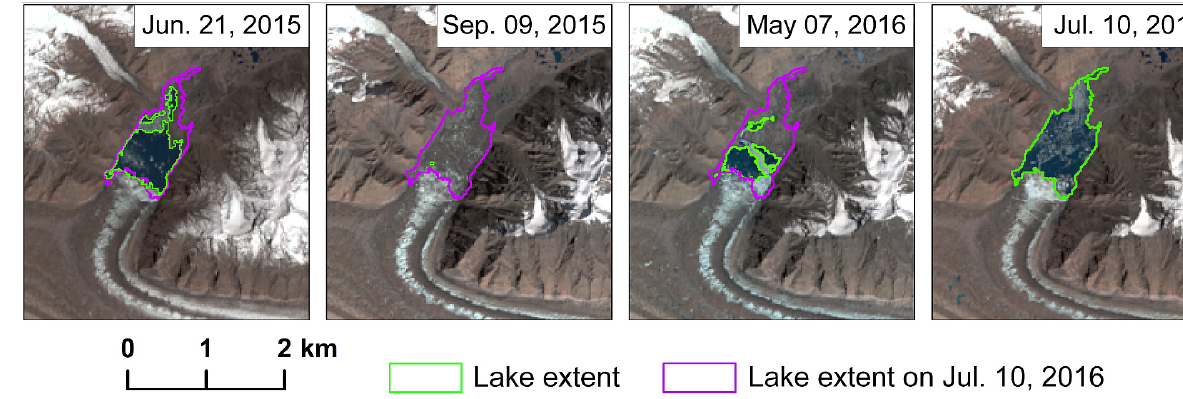
Figure 7. Temporal development and sudden drainage of Lake Merzbacher (79.89°E, 42.23°N).